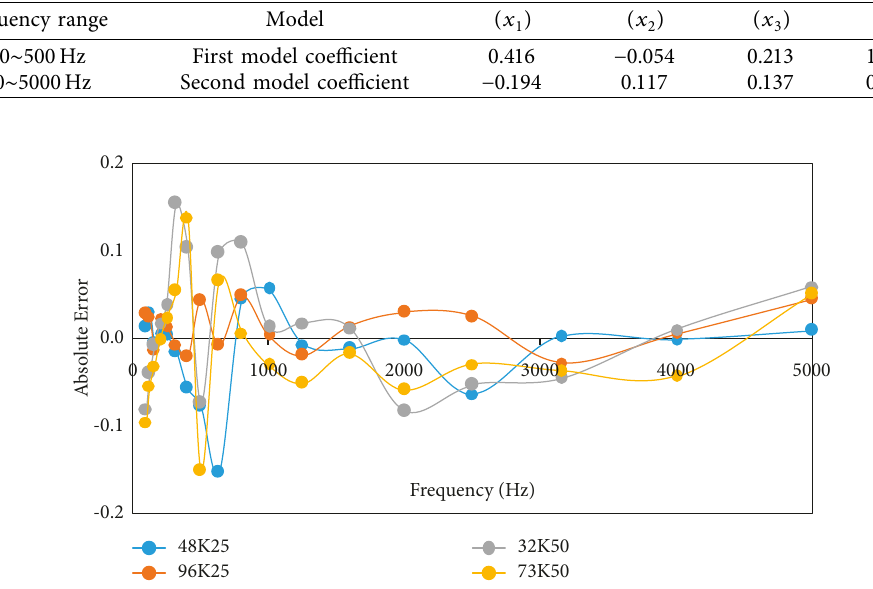
Table 5: Regression coefficients.